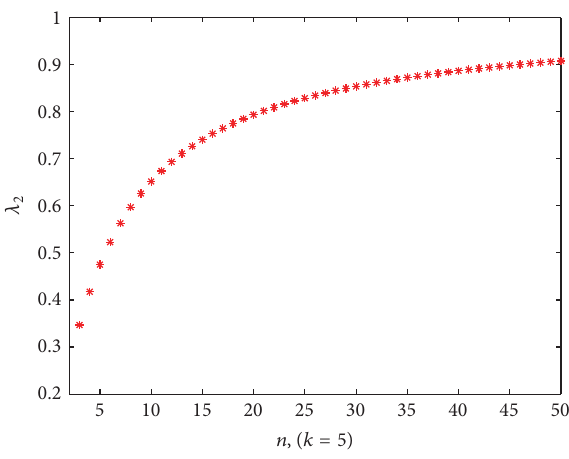
Figure 3: The variance of 𝜆 2 for 𝐾 𝑛 ∘ 𝑃 5